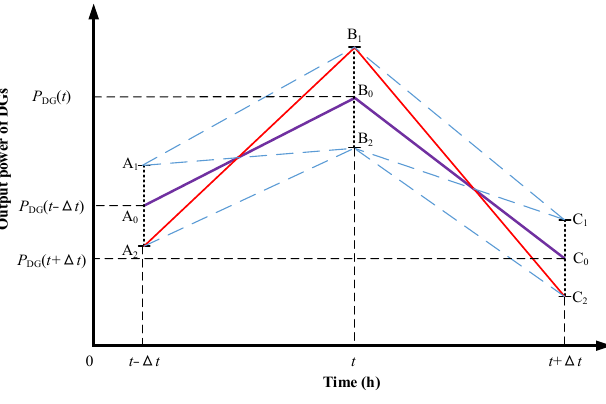
Figure 2. Output power of DGs.